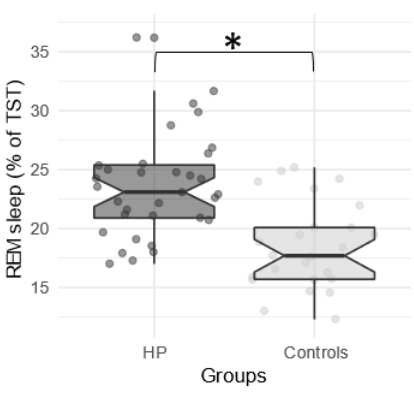
Figure 1. Each point represents the median Rapid Eye Movement (REM) sleep percentage for each subject according to the group (High Potential (HP) vs. controls). The central line of the boxplot corresponds to the median; the upper and lower parts correspond to the first and third quartiles. Difference between groups is represented by a star: * p < 0.05. Table 2. Characteristics of the Polysomnography (PSG) for children with HP and controls. Controls